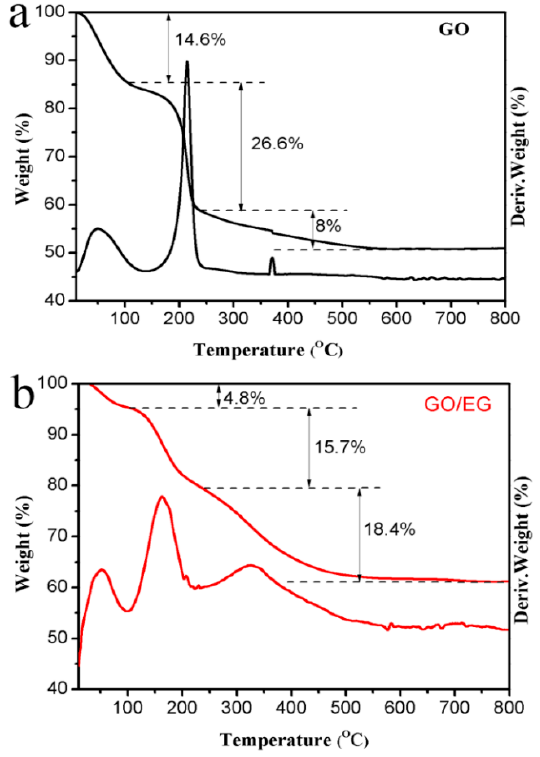
Figure 3. ( a ) TGA curve and ( b ) DTG curve of GO and GO/EG under N 2 atmosphere (10 mL/min) at a heating rate of 10 °C/min.